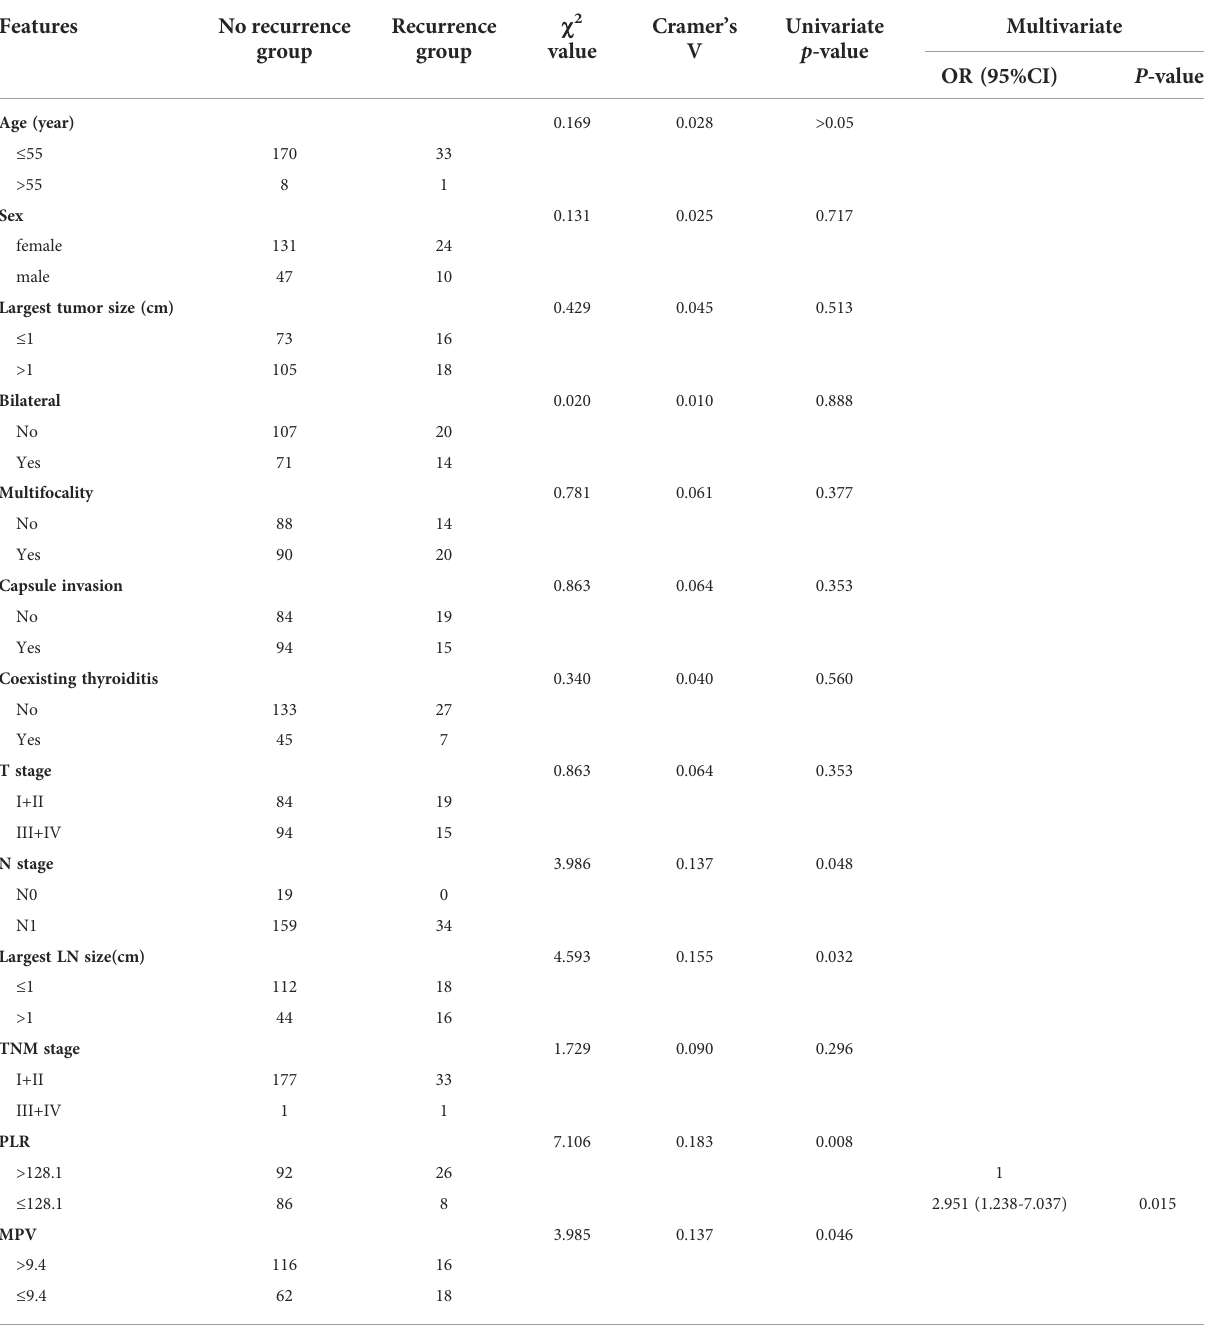
TABLE 4 Univariate and multivariate regression analyses of the possible risk factors for